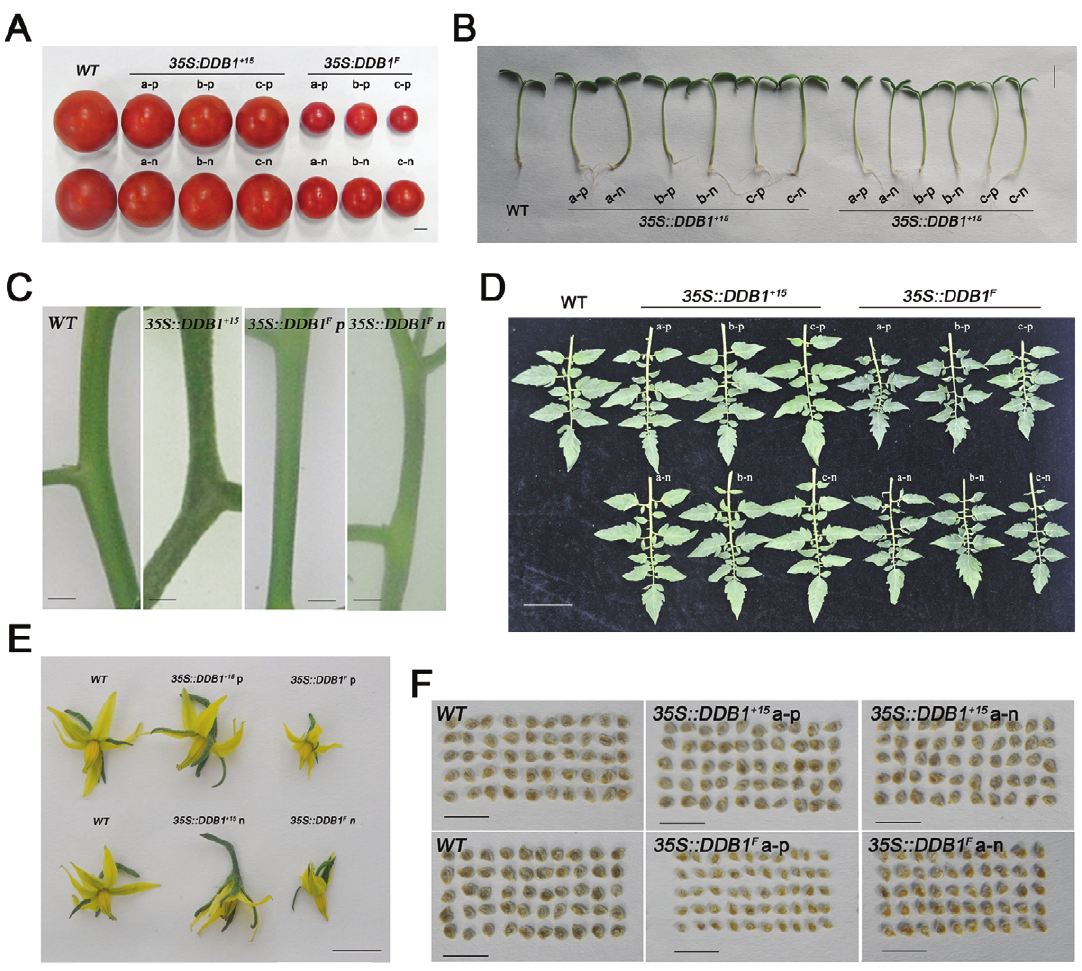
Figure 3. Organ size reduction in DDB1 F overexpression line. (A) Representative red ripe fruits from field-grown plants of WT Ailsa Craig ( WT ), 35S::DDB1 + 15 and 35S::DDB1 F T 2 transgenic lines (a, b, c). Bar=1 cm. (B) Representative 7-day-old seedlings of WT Ailsa Craig ( WT ), 35S::DDB1 + 15 and 35S::DDB1 F T 2 transgenic lines (a, b, c) germinated under white-light (16 h light/8 h dark photoperiod). Bar=1 cm. (C) Comparison of stems from WT Ailsa Craig ( WT ), 35S::DDB1 + 15 and 35S::DDB1 F T 2 transgenic lines, showing the reduction in stem size. Bar=1 cm. (D) Comparison of mature leaves from WT Ailsa Craig ( WT ), 35S::DDB1 + 15 and 35S::DDB1 F T 2 transgenic lines (a, b, c). Bar=5 cm. (E) Comparison of flowers from WT Ailsa Craig ( WT ), 35S::DDB1 + 15 and 35S::DDB1 F T 2 transgenic lines. Bar=1 cm. (F) Comparison of seeds from WT Ailsa Craig ( WT ), 35S::DDB1 + 15 and 35S::DDB1 F transgenic lines. p and n represent plants with or without transgene, respectively. Bar=1 cm.